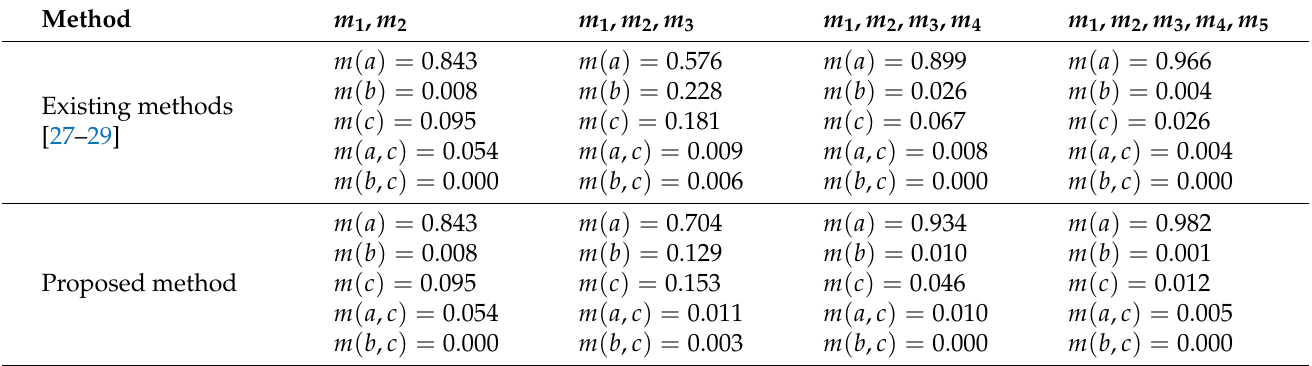
Table 8. The result of combining conflicting evidence with different methods in the Example 13.